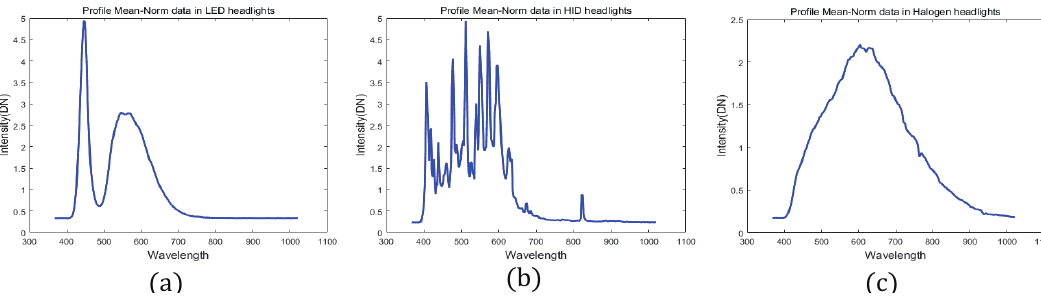
Figure 5. Comparison of the spectral profiles after preprocessing in the Mean-Norm ( a ) LED headlight ( b ) HID headlight ( c ) Halogen headlight.